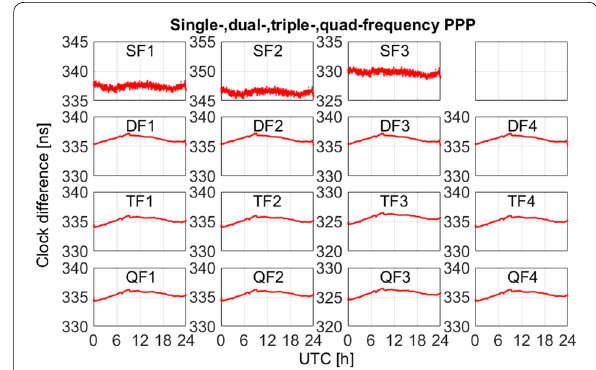
Fig. 4 Clock differences of the BDS single-, dual-, triple- and quad-frequency PPP for the time-link BRCH–XIA3 on DOY 17, 2019